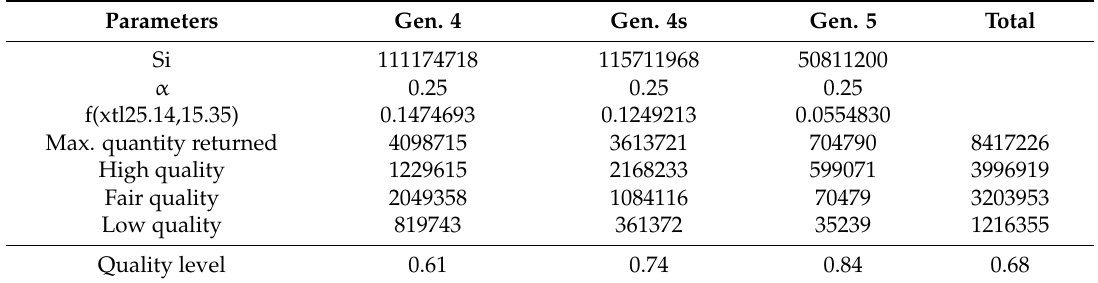
Table 3. Maximum quantity returned and average quality level of each generation during the